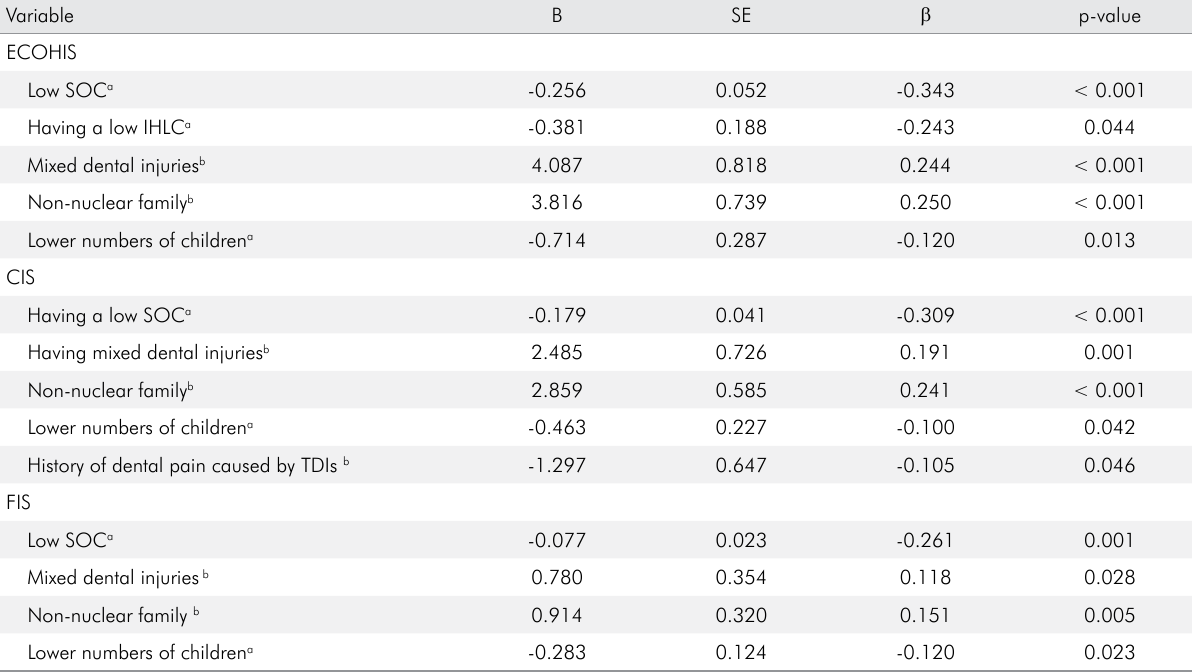
B: non-standardized regression coefficient; SE: standard error; β : standardized regression coefficient; TDIs: traumatic dental injuries; ECOHIS: Early Childhood Oral Health Impact Scale; CIS: child impact section; FIS: family impact section; SOC: sense of coherence; IHLC: internal health locus of control. a Continuous variables: SOC, IHLC, and number of children. b Dichotomized variables: mixed dental injuries (1 = yes vs. 0 = no), a non-nuclear